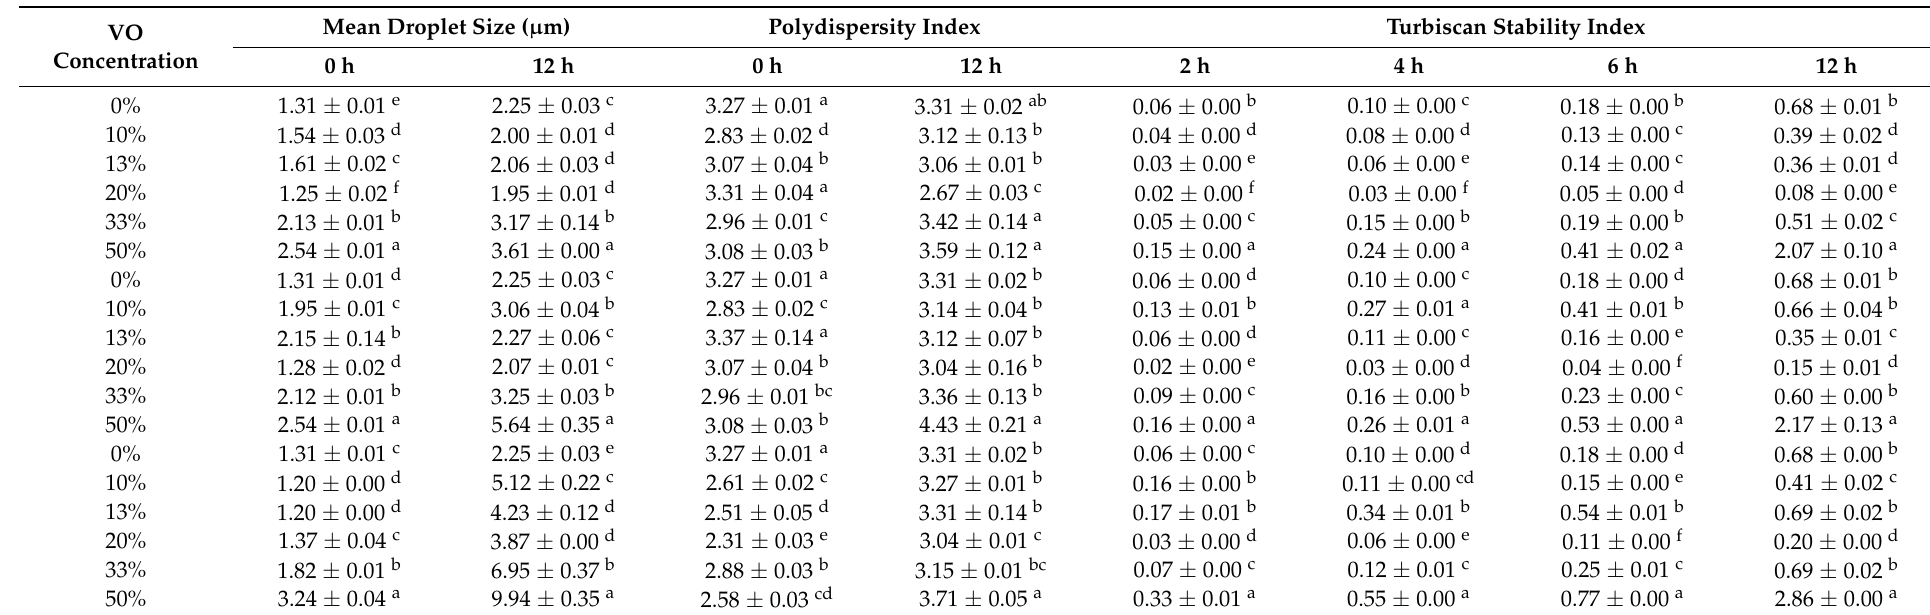
Table 2. Droplet-size distribution, polydispersity index and Turbiscan stability index of GEO and GEO-VO emulsions.